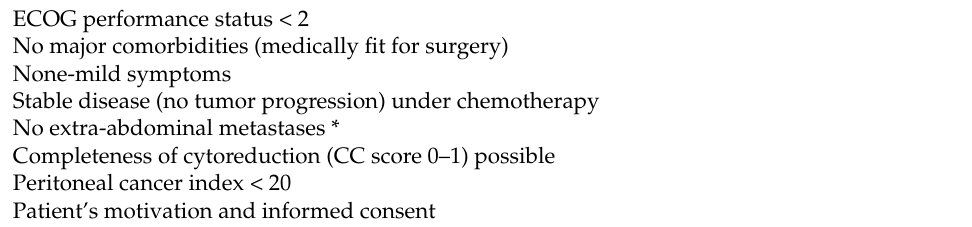
Table 3. Selection Criteria for CRS ± HIPEC for CRC with Peritoneal